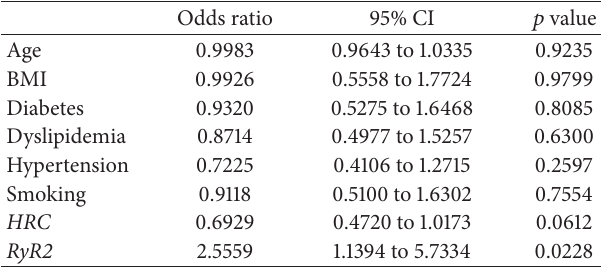
Table 4: Multiple logistic regression analysis. Table 5: Genotypic frequency of RyR2 Q2958R in the study population subgroups according to arrhythmias